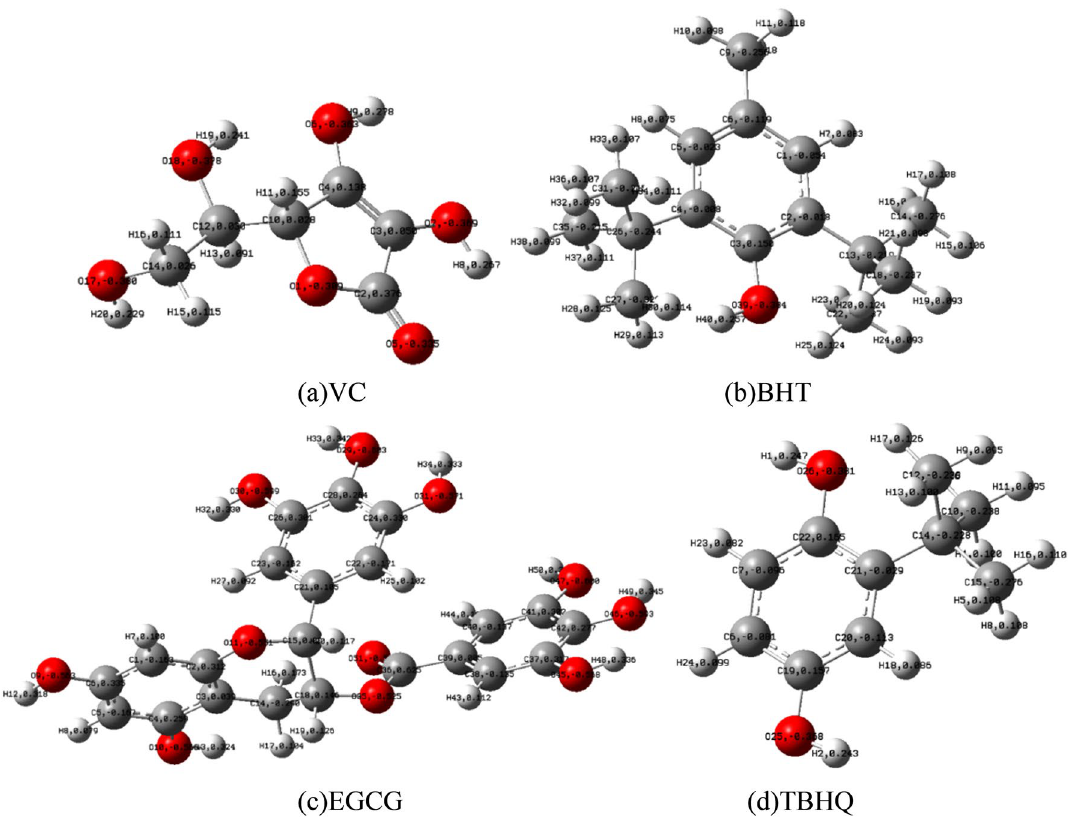
Figure 6. The Mulliken charges of the four antioxidants. Bond length Charge Antioxidants